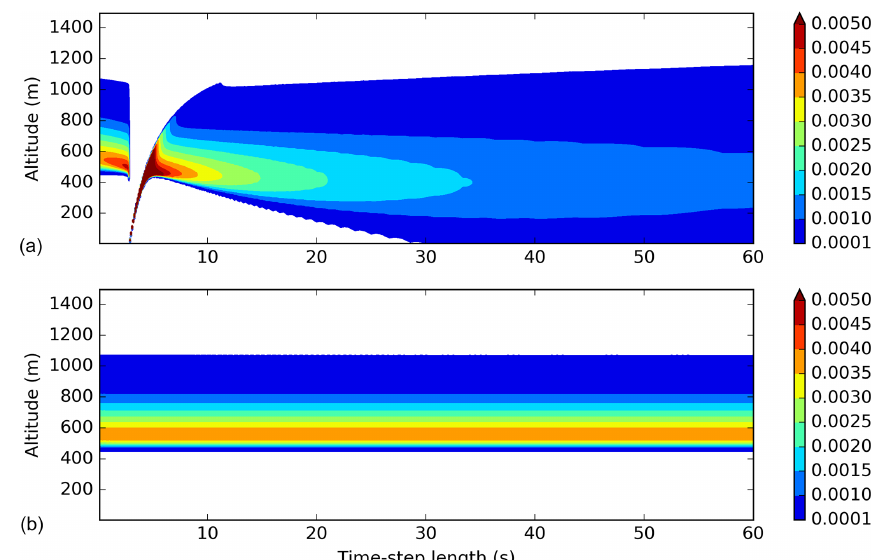
Figure 11. Vertical profiles of the rain mixing ratio (the color scale represents the mixing ratio in gkg − 1 ) after a 400s long integration for different time steps (600 simulations are performed using time steps between 0.1 and 60s with an increment of 0.1s, abscissa) for the